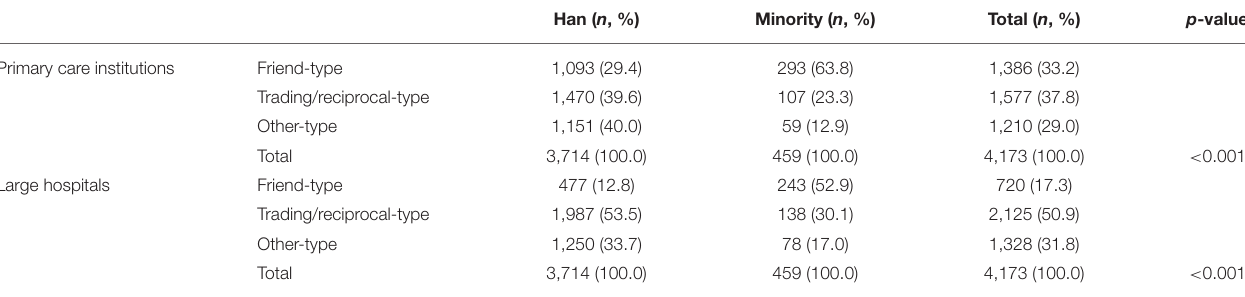
TABLE 3 | Han and minority perceived D-P relationship in primary care institutions and large